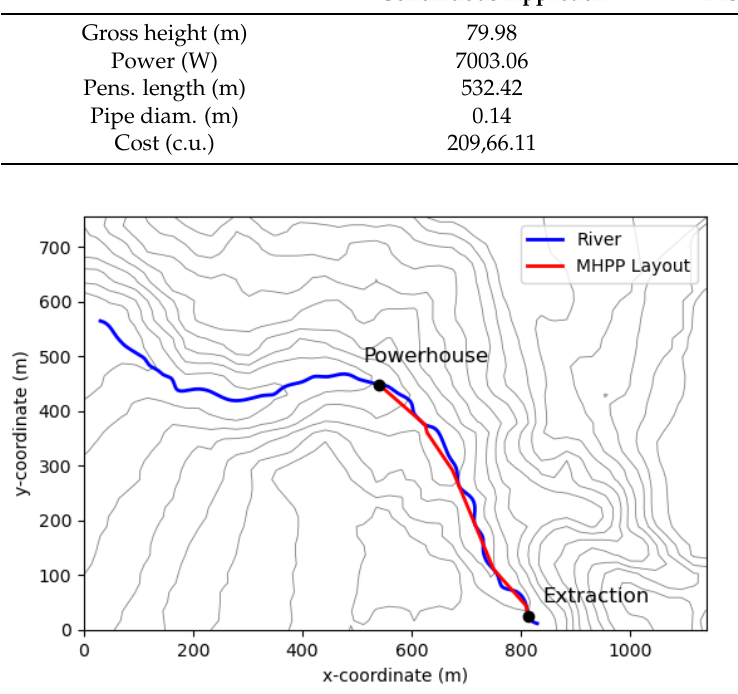
Figure 15. Optimal solution obtained using the discrete approach from